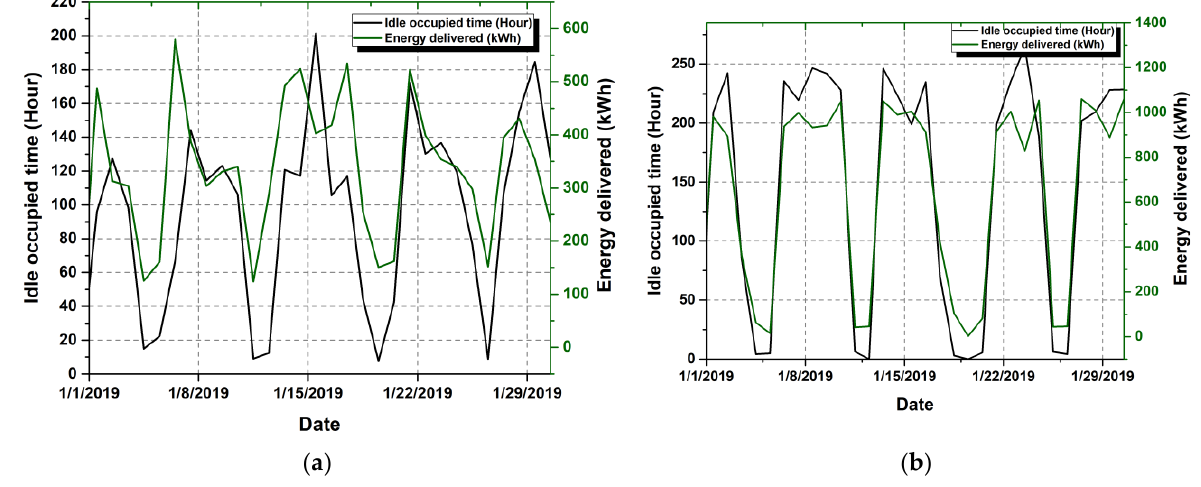
Figure 7. Idle occupancy vs. energy delivered. ( a ) Caltech. ( b ) JPL. Table 3. Average idle occupancy (hour) per session.